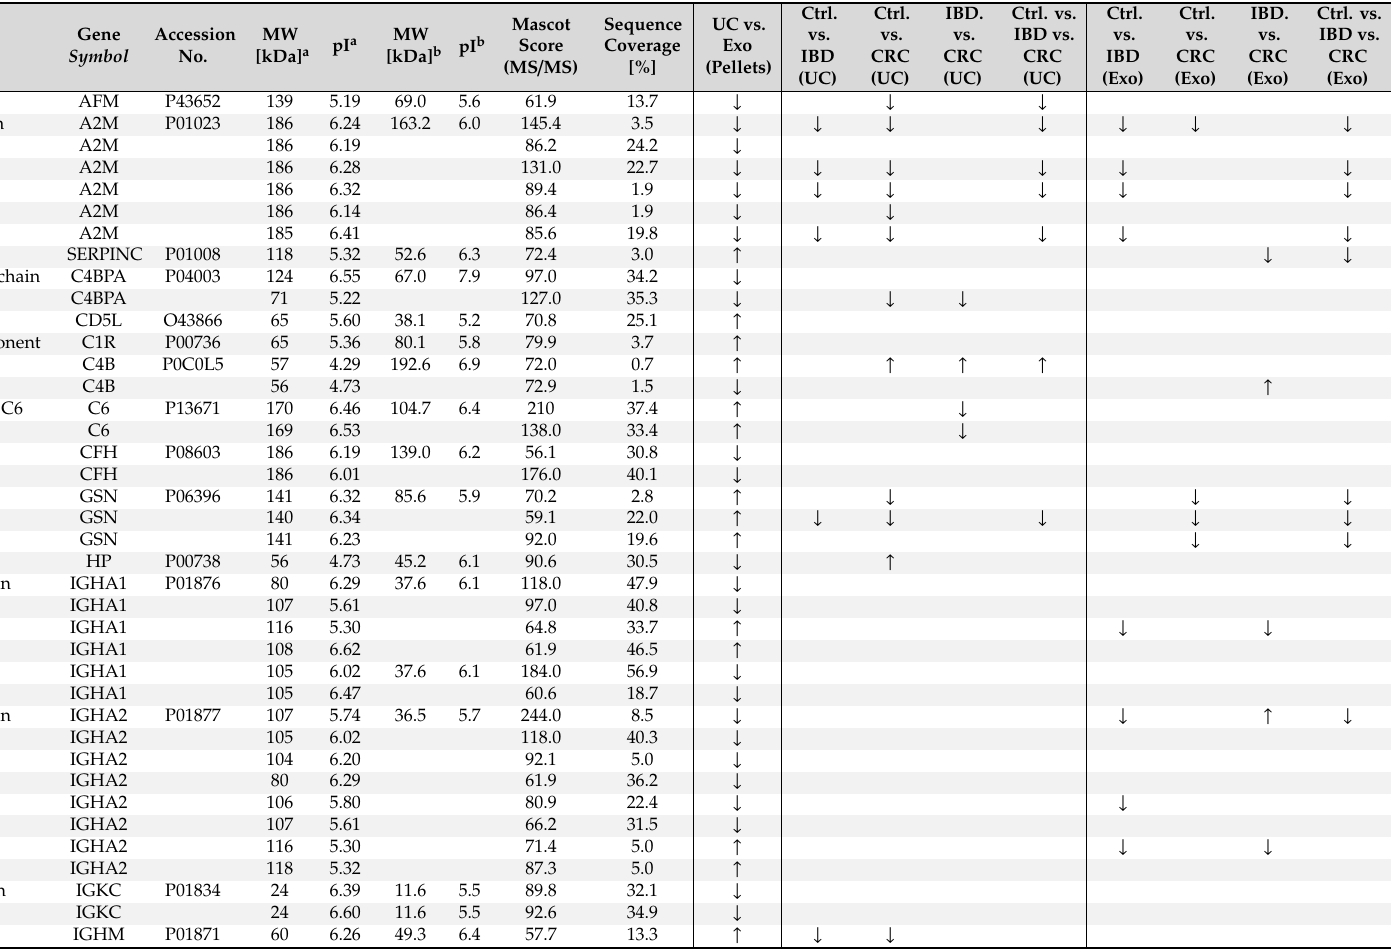
Table 2. Summary of identified EV proteins using MALDI-TOF /